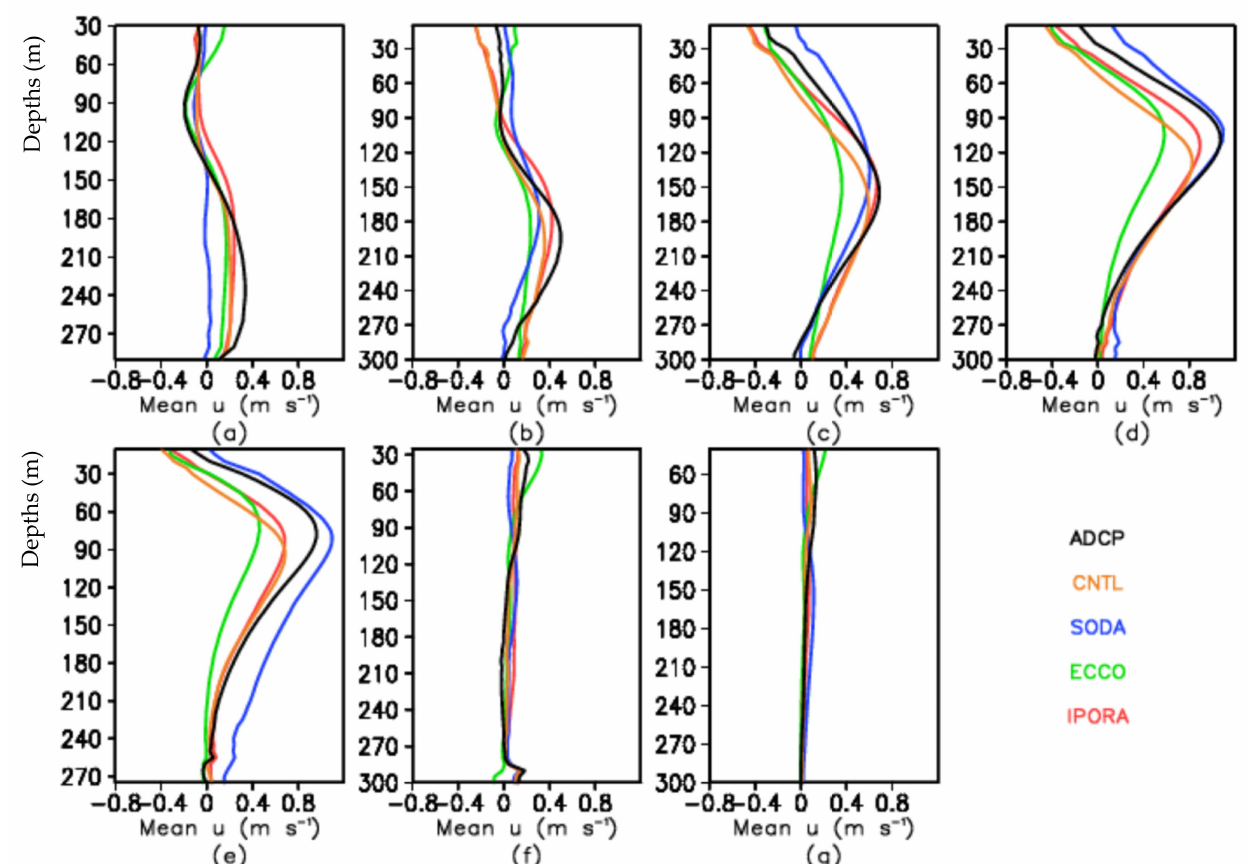
Figure 11. Temporal mean vertical profiles of the zonal current at seven moorings in the TAO/RAMA array compared with CNTL, IPORA, ECCO, and SODA. ( a ) (0 ◦ N, 147 ◦ E), ( b ) (0 ◦ N, 165 ◦ E), ( c ) (0 ◦ N, 170 ◦ W), ( d ) (0 ◦ N, 140 ◦ W), ( e ) (0 ◦ N, 110 ◦ W), ( f ) (0 ◦ N, 80.5 ◦ E), and ( g ) (0 ◦ N, 90 ◦